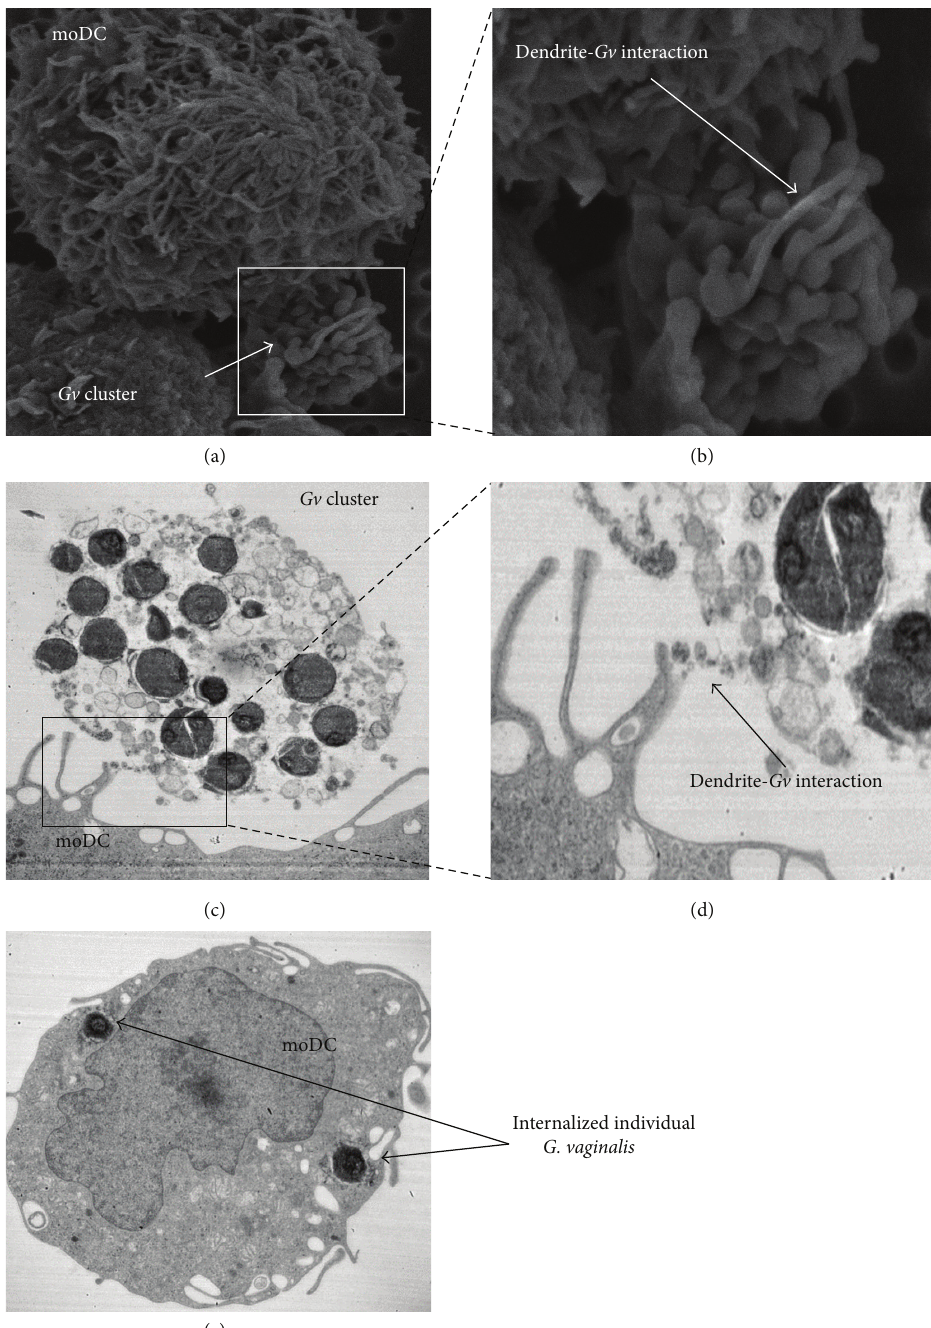
Figure 1: Pictures of DCs after exposure to G. vaginalis . (a) SEM ( × 5500), after a 1h exposure, DC dendrites surrounding clusters of G. vaginalis. (b) Zoom ( × 13000) on the contact zone between DCs and bacteria. (c) TEM ( × 12000), after a 3 h exposure, a cluster of G. vaginalis in contact with DC dendrites. (d) Enlargement of DC dendrite- G. vaginalis interaction zone. (e) TEM cutting, internalized G. vaginalis in one DC. moDC: monocyte-derived dendritic cell, Gv: Gardnerella vaginalis